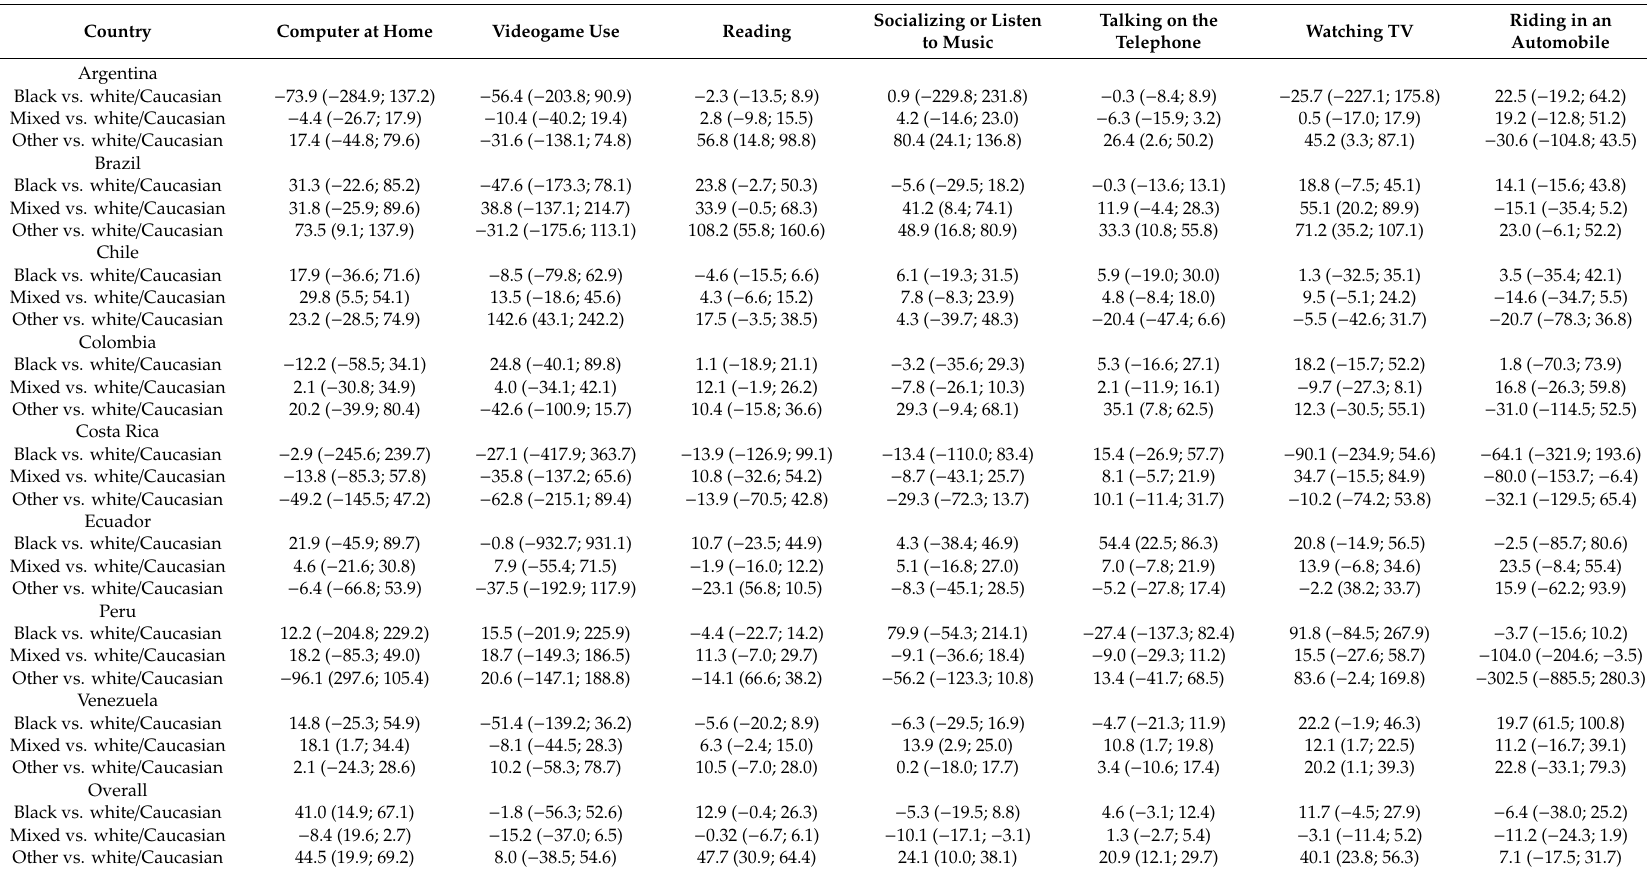
Socializing or Listen Talking on the Riding in an Watching TV to Music Telephone Automobile